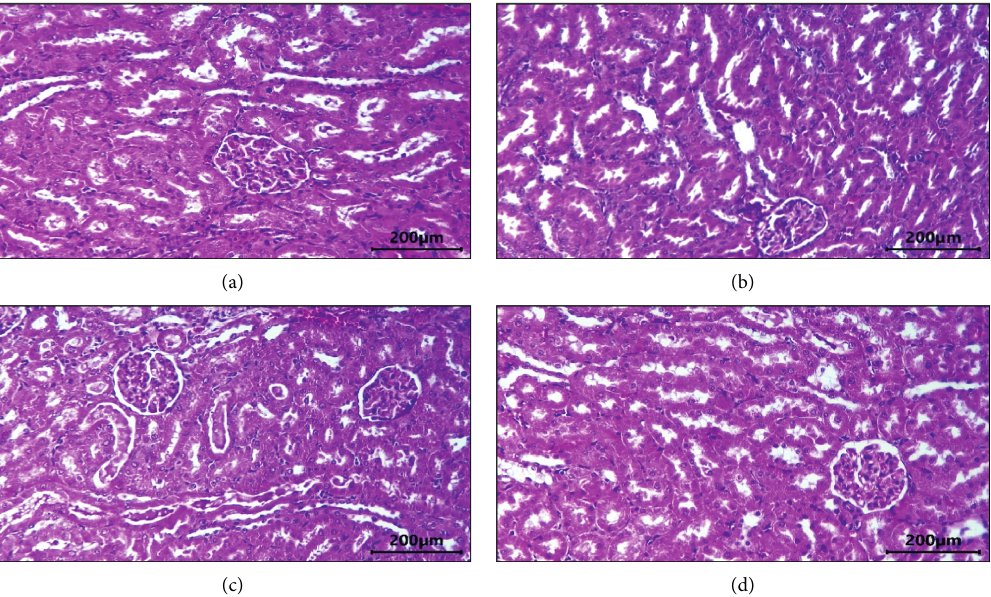
Figure 3: The kidney histology after administration of neem leaf ethanolic extracts in male rats: (a) control group, (b) treated group � 100mg/kg, (c) treated group � 200mg/kg, and (d) treated group �